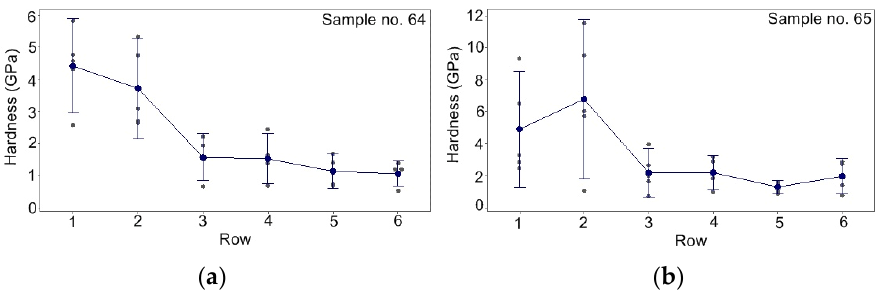
Figure 7. Development of local hardness (95% confidence interval) as a function of distance from the sample surface (individual standard deviations are used to calculate the intervals): ( a ) Sample 64; ( b ) Sample 65.